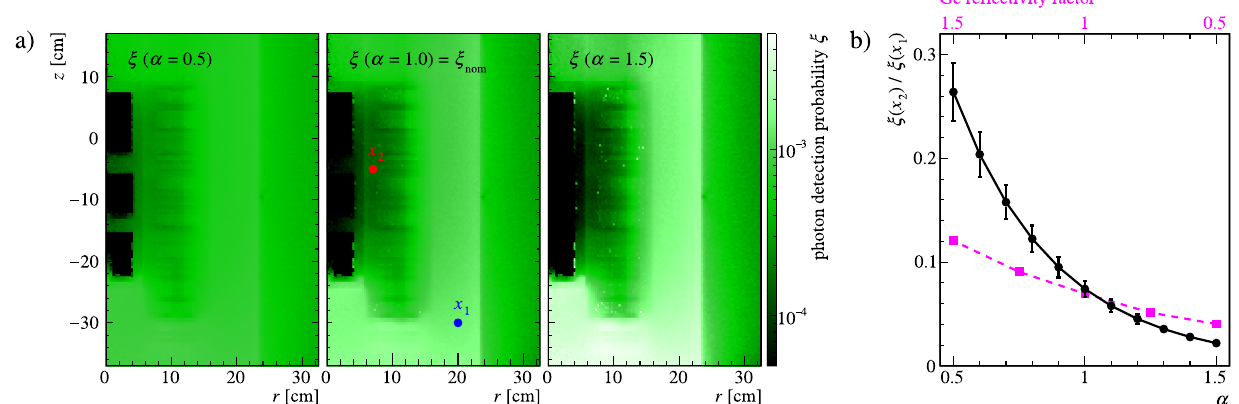
Fig. 6 Modification of the photon detection probability ξ( (cid:6) x ) through analytical power-law distortions defined in Eq. 8. a Inhomogeneities that are present in the nominal map are amplified with increasing α , leading to a more homogeneous ( α < 1, i.e.less color contrast) or less homogeneous ( α > 1, i.e.more color contrast) response. b The prob-